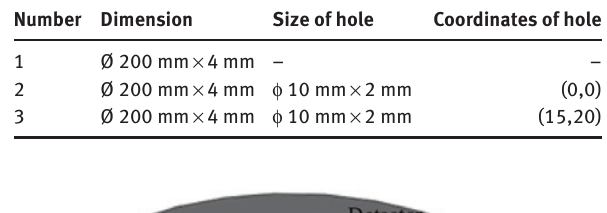
Table 2: Characteristics of the models. Number Dimension